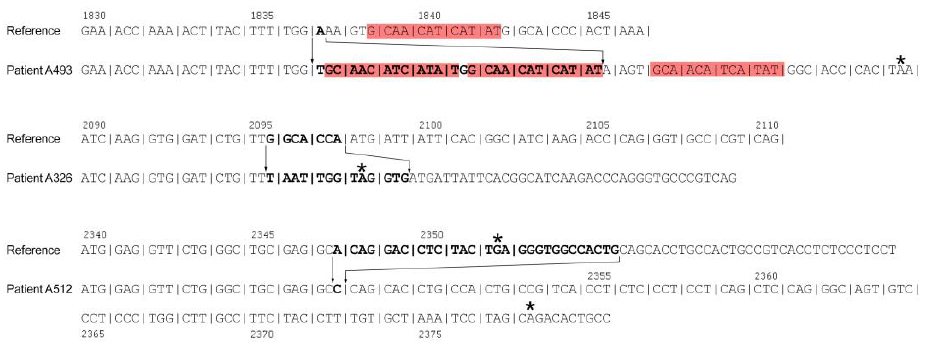
Figure 3. Nucleotide sequences of three new complex indels in the F8 gene. Red boxes indicate triplicated nucleotides, * indicates stop